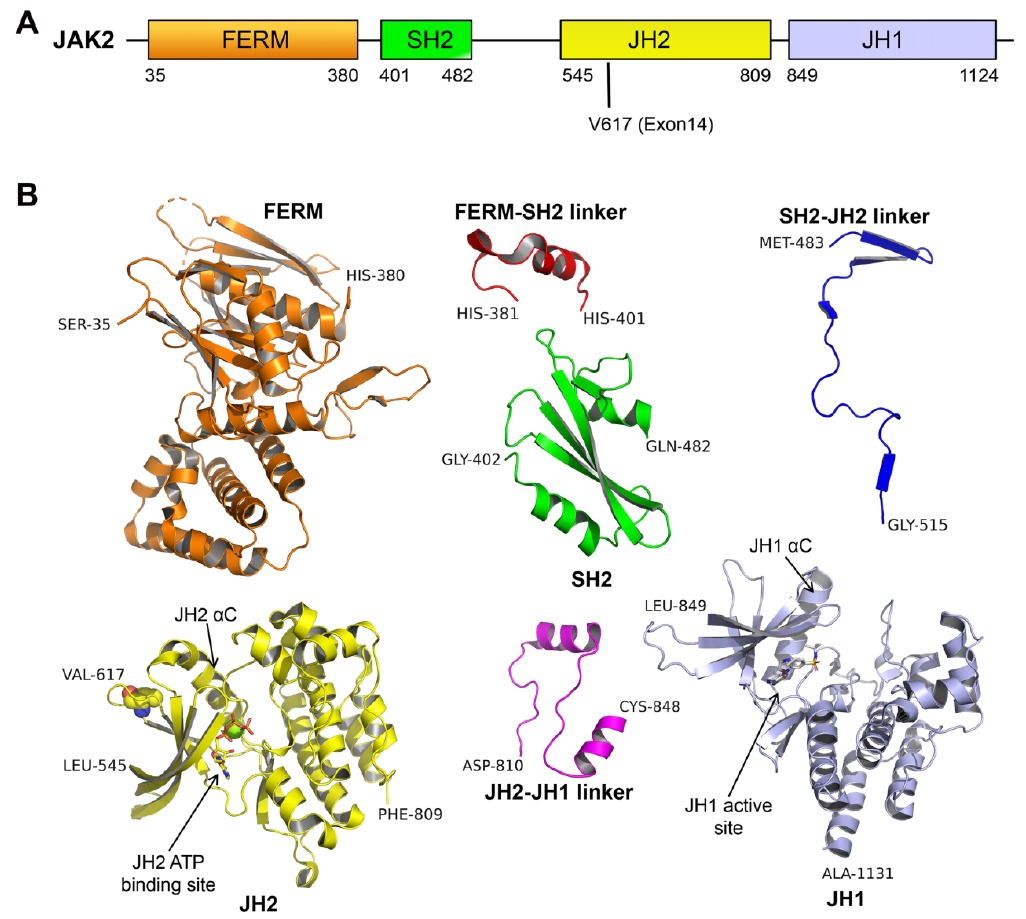
Figure 1. The structure of JAK2. ( A ) The domain organization of full length JAK2. ( B ) JAK2 domains and linkers were adapted from PDB and drawn in different colors. FERM (band 4.1, ezrin, radixin, moesin) domain colored in brown, SH2 (an Src homology 2) domain colored in green, JH2 (Jak-homology 2) domain colored in yellow, JH1 (Janus homology-1) domain colored in light blue, FERM-SH2 linker colored in red, SH2-JH2 linker colored in blue, and JH2-JH1 colored in magenta. FERM, FERM-SH2 linker, SH2, and SH2-JH2 linker (PDBID: 6E2Q); JH1 (PDBID: 6VNE); JH2 (PDBID: 5I4N); and JH1-JH2 linker (PDBID: 4OLI).